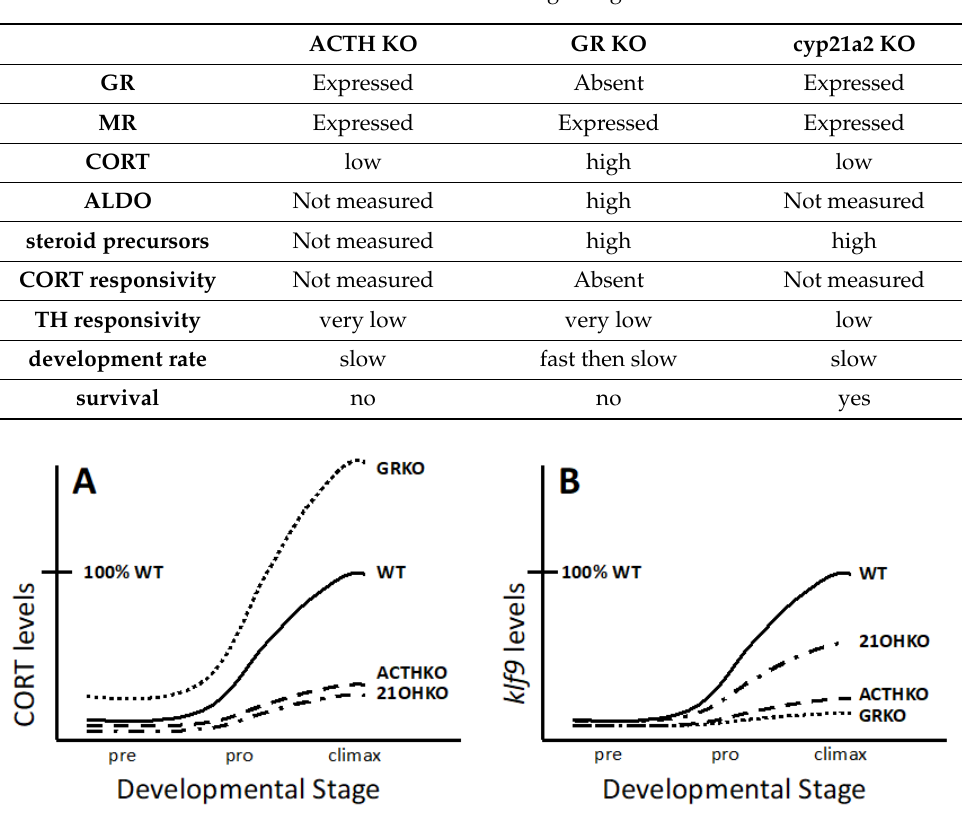
Figure 4. Levels of plasma CORT and klf9 expression in corticosteroid mutant frogs. ( A ). Compared to wild-type (WT) tadpoles, glucocorticoid receptor knockout (GRKO) tadpoles have high corticosterone (CORT) levels from lack of negative feedback, adrenocorticotropic hormone knockout (ACTHKO) tadpoles have low CORT levels from lack of adrenal stimulation by ACTH,